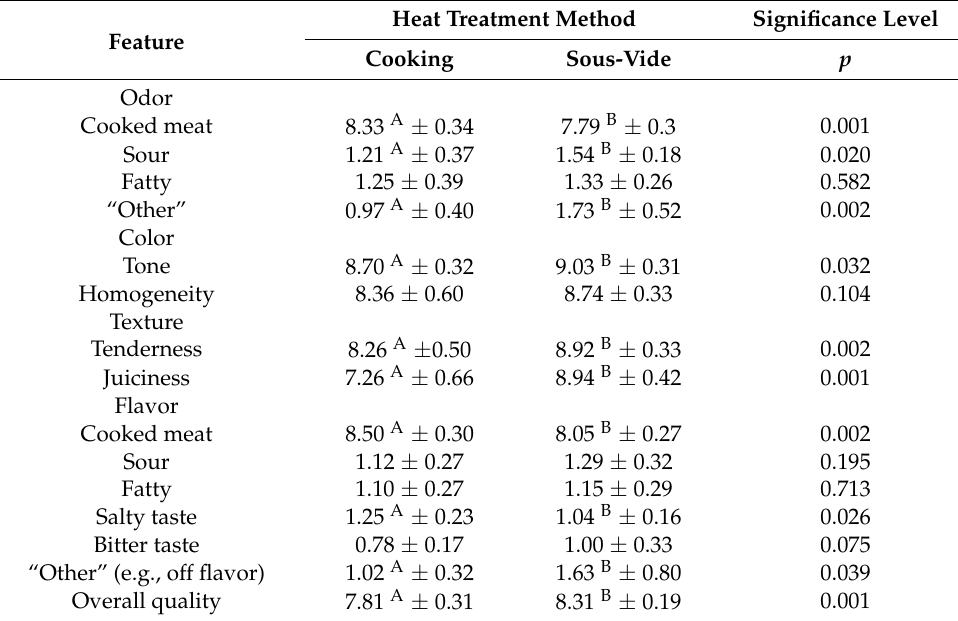
Table 4. Characteristics of sensory quality of meat after heat treatment (0–10 c.u.), n =